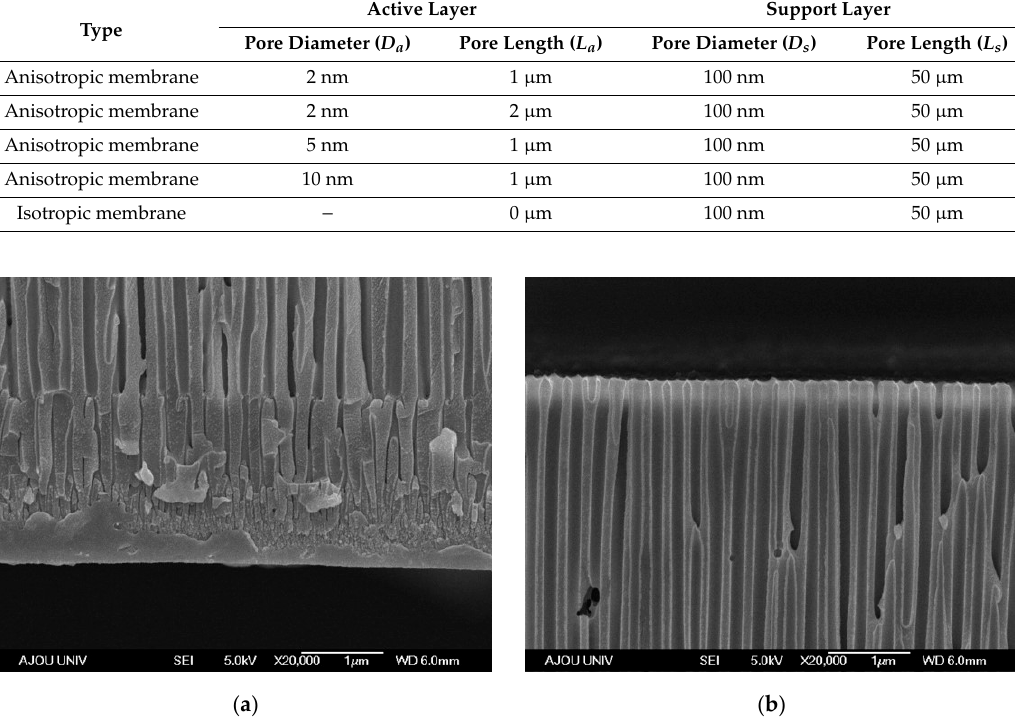
Figure 3. Scanning Electron Microscope (SEM) cross-sectional view of the anisotropic nanoporous anodic aluminum oxide membrane: ( a ) active layer side; (b) support layer side. Table 1. Dimensions of the nanoporous aluminum oxide membranes used in the study.